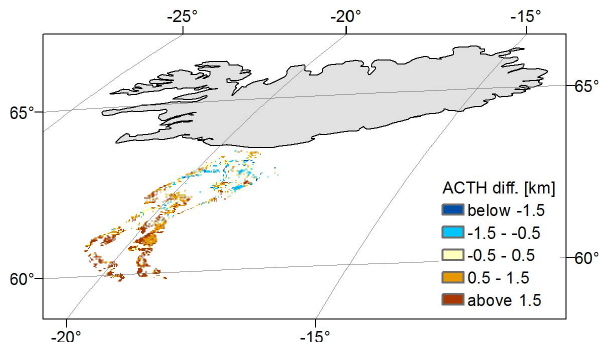
Fig. 11. ACTH difference (proposed minus MISR ACTH) between the case study estimate and MISR measurements on 19 April at